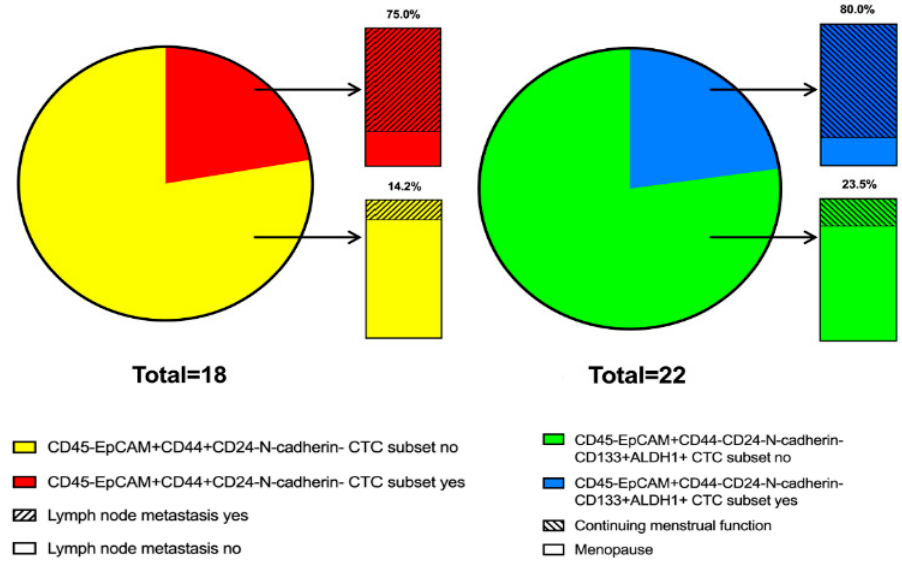
Figure 6. Association of CTC subsets with lymph-node metastasis and menstrual function in breast-cancer patients.